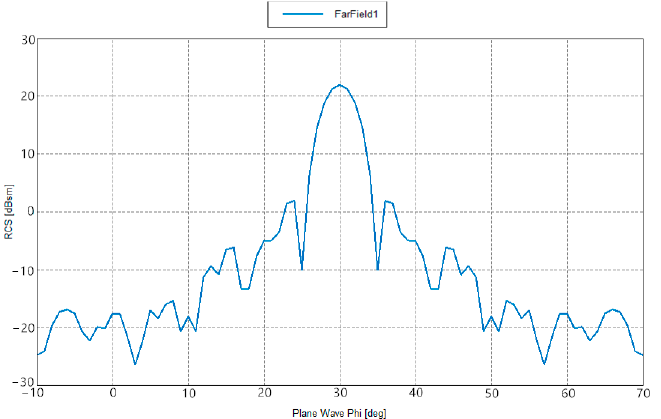
Figure 4. Radar cross-section distribution characteristics with a pitching angle of 55°.